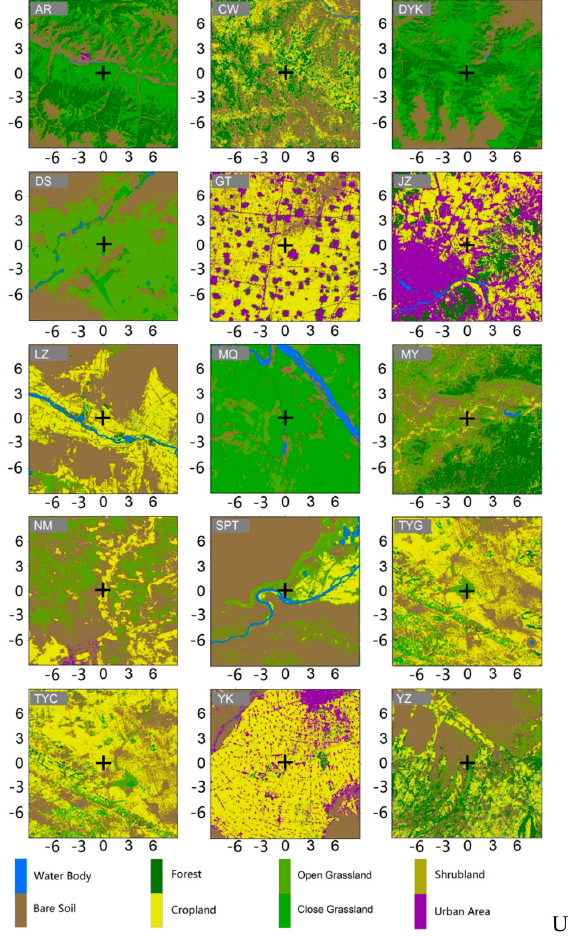
Figure 8. Land cover maps of the 15 sites at a 30 m resolution for each area (18 km × 18 km) centered at individual flux sites.